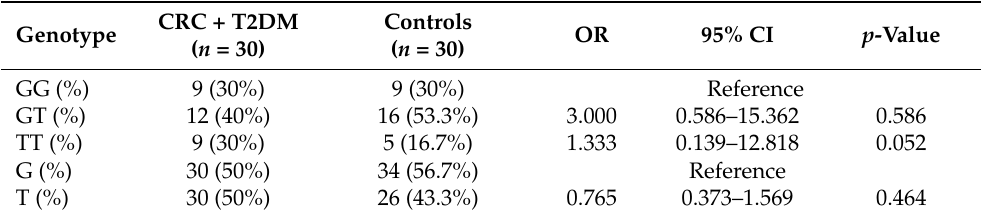
Table 6. Genotype and allele distribution and analysis of the association of rs6983267 of CASC8 in subjects with CRC + T2DM and